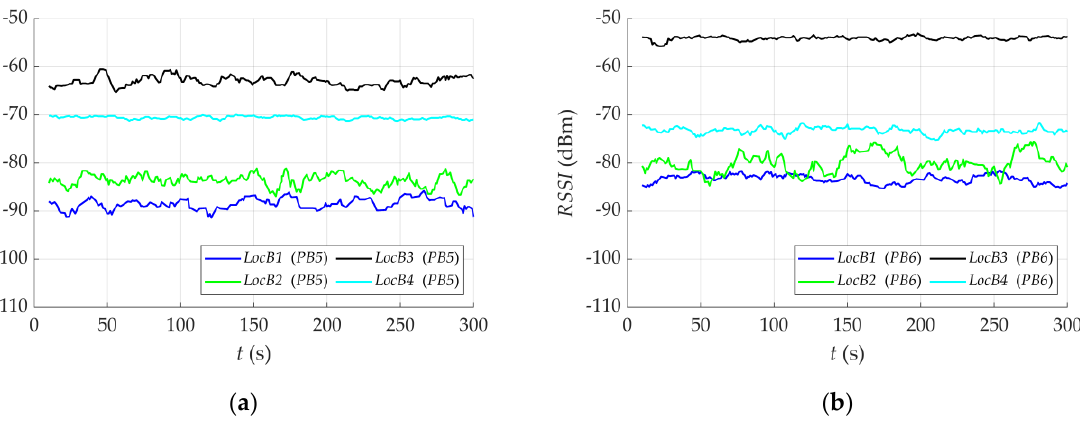
Figure 17. RSSI sequences averaged in a moving window with a width of M = 10 for four locator nodes and an object placed in front of the LocB3 receiver at a distance of ( a ) 2.5 m (location PB5 ); ( b ) 1.0 m (location PB6 ).